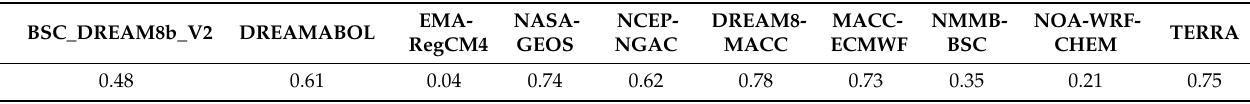
Table 3. Statistical results (R 2 ) from the evaluation of the forecasted AODs of each model against AODs at 3 AERONET stations in the Middle East (Kuwait University, KAUST-campus and Masdar Institute) during the 12 dust